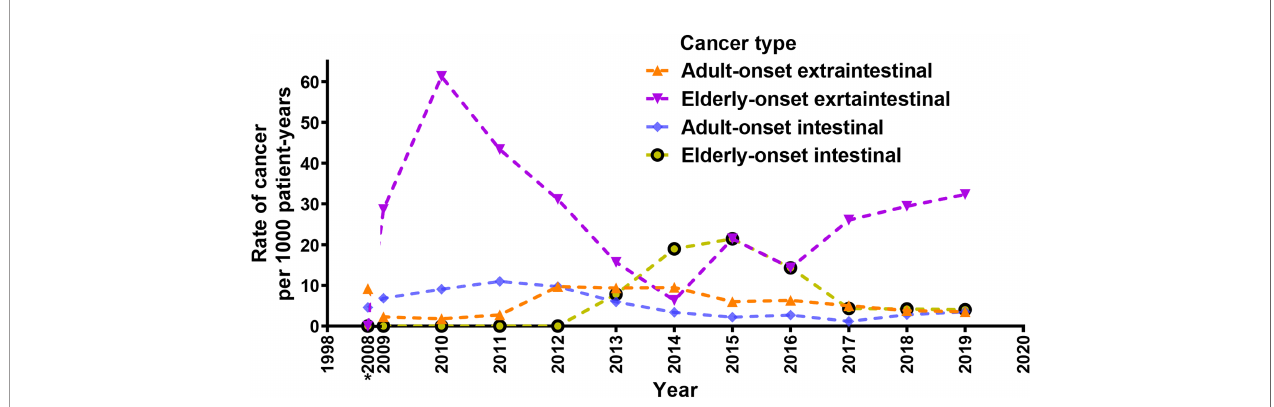
FIGURE 3 | Crude rates of elderly-onset IBD and adult-onset who developed intestinal or extra-intestinal cancers presented as 3-year moving averages from 2009 to 2019. *Accumulated incidence rate of cancer from 1998